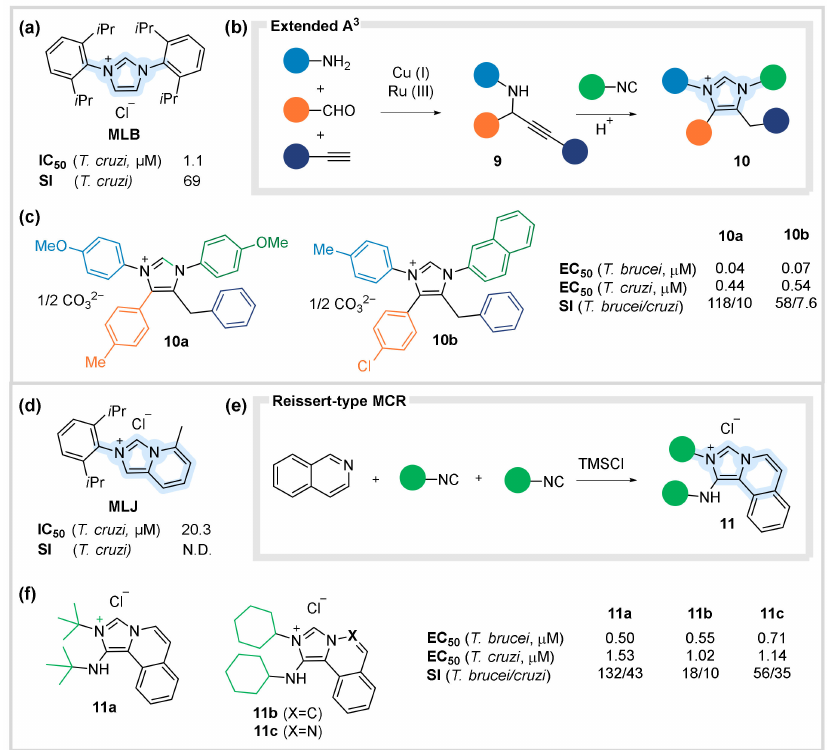
Figure 5. MCR-based antiparasitic agents. ( a ) Imidazolium salt MLB with antiparasitic activity against Chagas disease. ( b ) MCR pathway to tetrasubstituted imidazolium salts. ( c ) Biological activities of promising derivatives. ( d ) Benzimidazolium salt MLJ with mild antiparasitic activity against Chagas disease. ( e ) TMSCl-promoted MCR synthesis of benzimidazolium salts. ( f ) Biological activities of selected